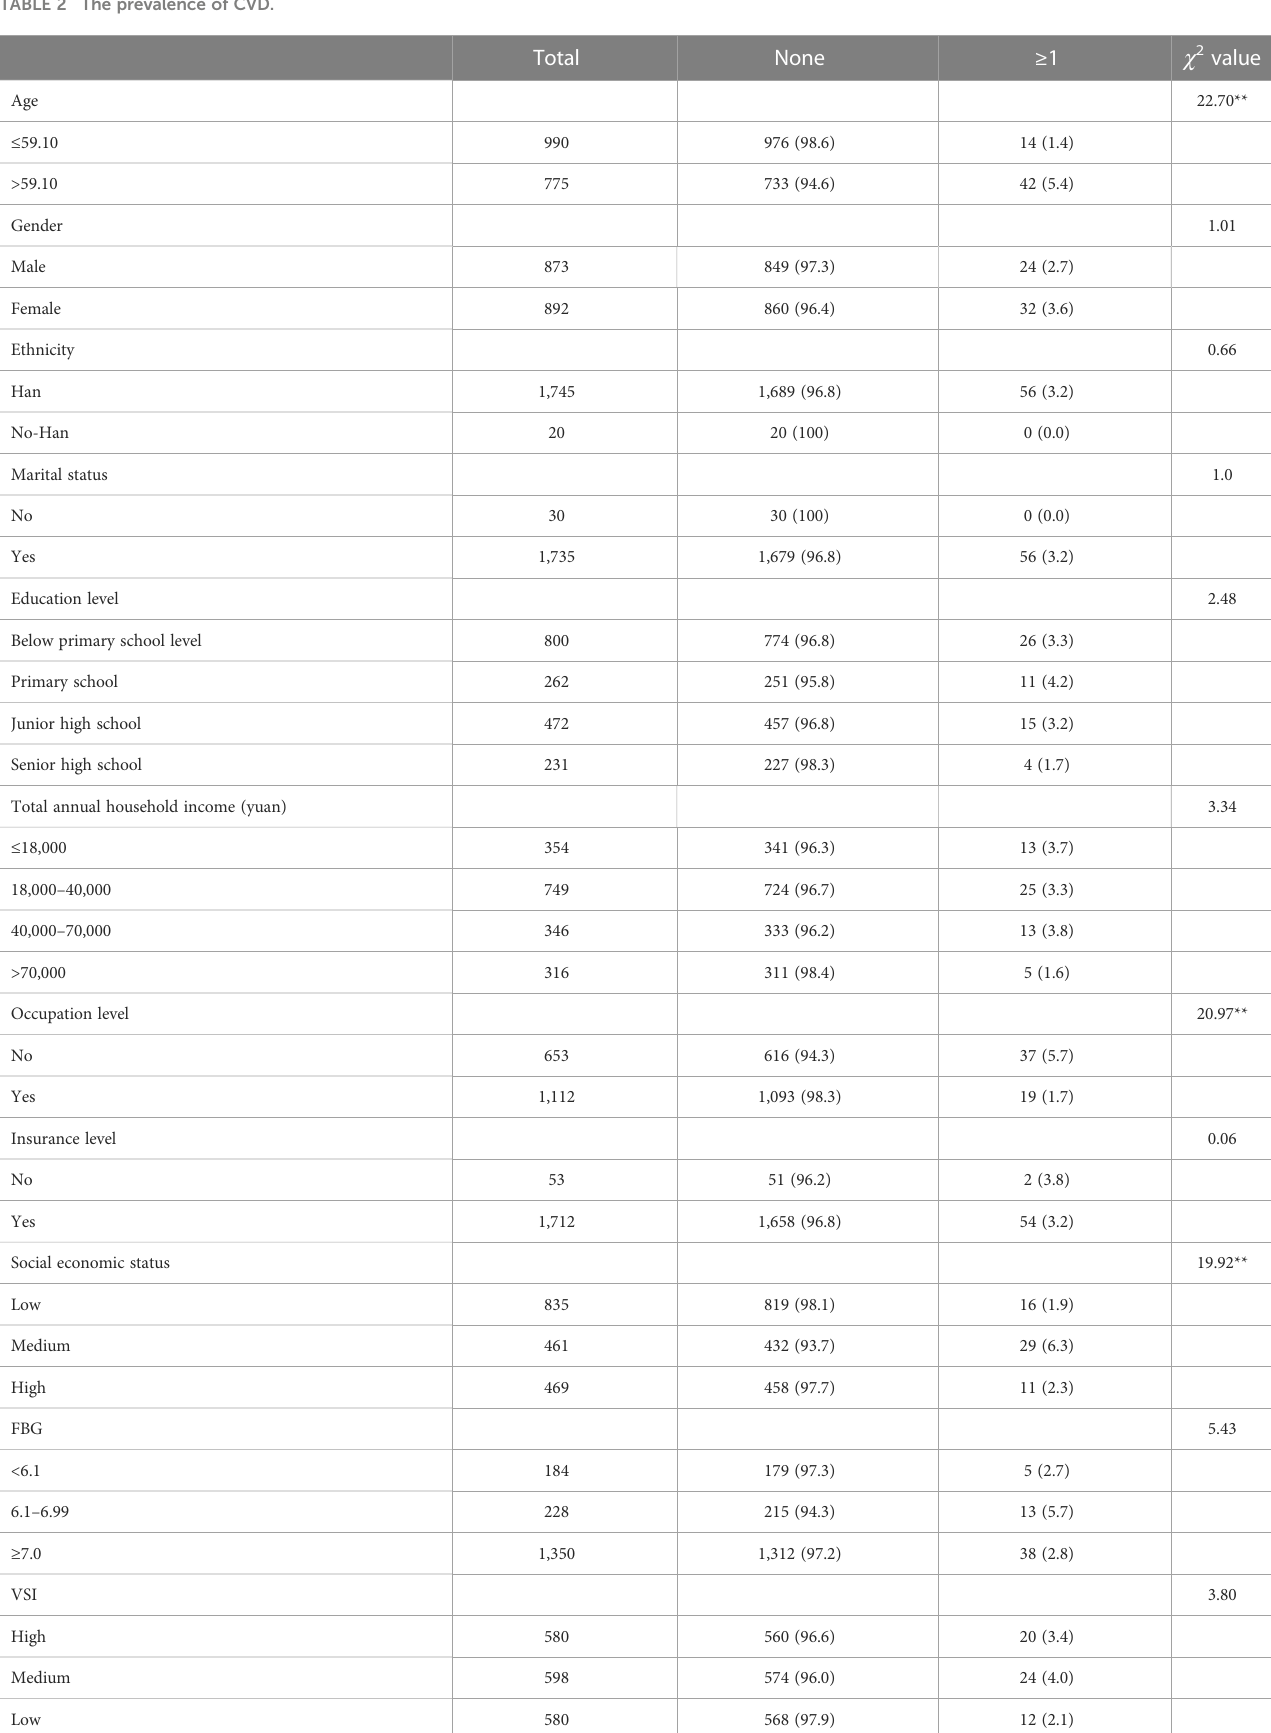
TABLE 2 The prevalence of